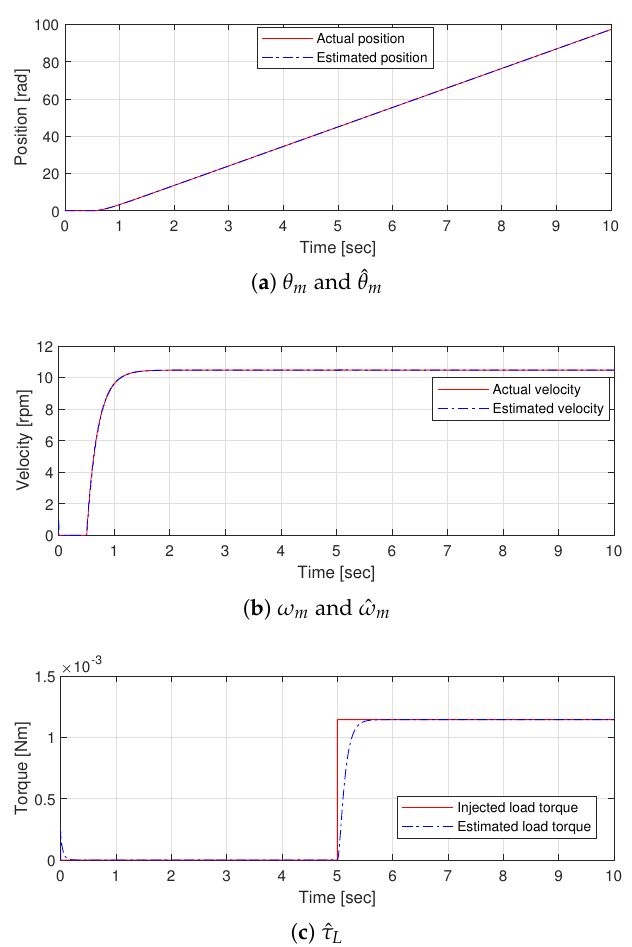
Figure 6. Estimation performance of the proposed augmented observer.